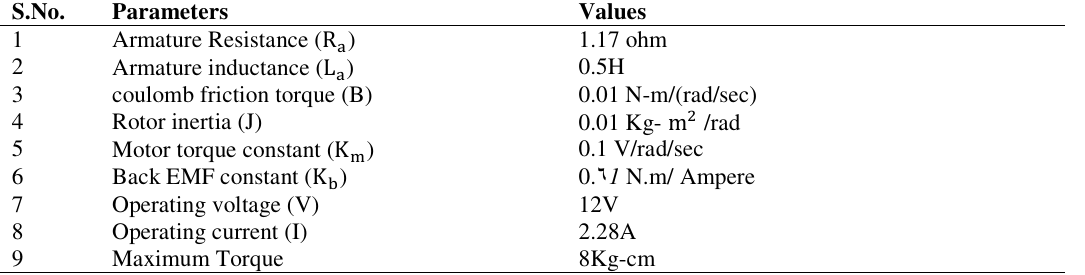
Fig. 5. Block diagram of DC servo motor [23]. Actual DC Servo Motor Parameters [23].